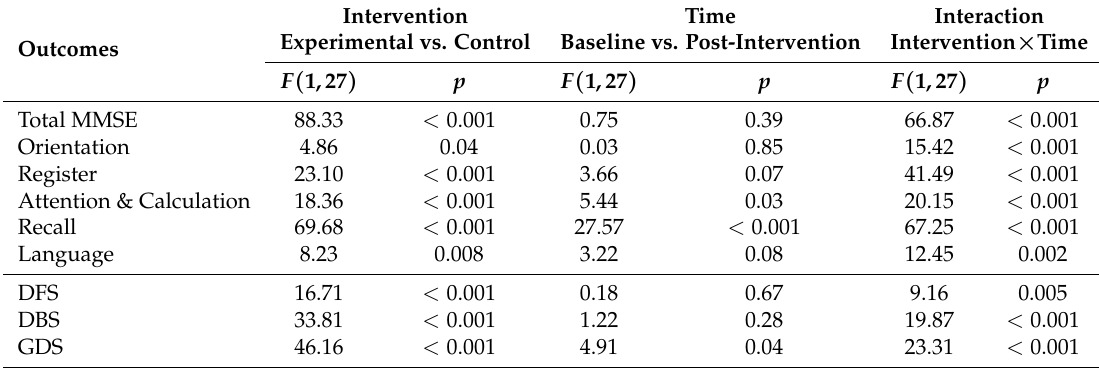
Table A5. The results of a two-way mixed model ANOVA for intervention (i.e., between-subjects effect) and time (i.e., within-subjects effect).